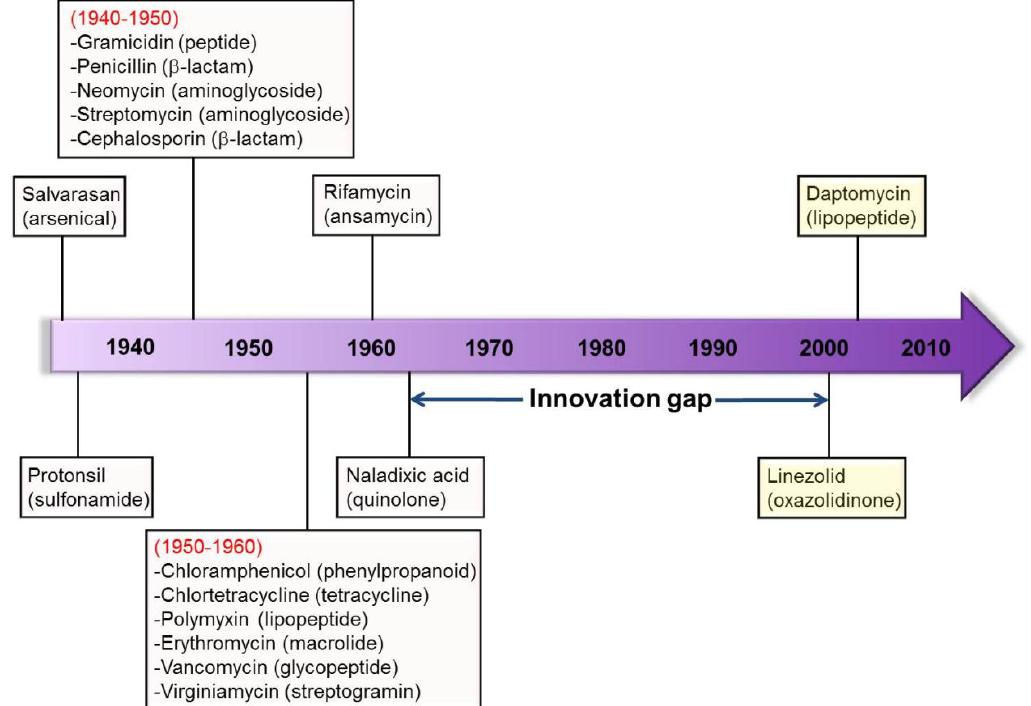
Figure 4. The emergence of novel